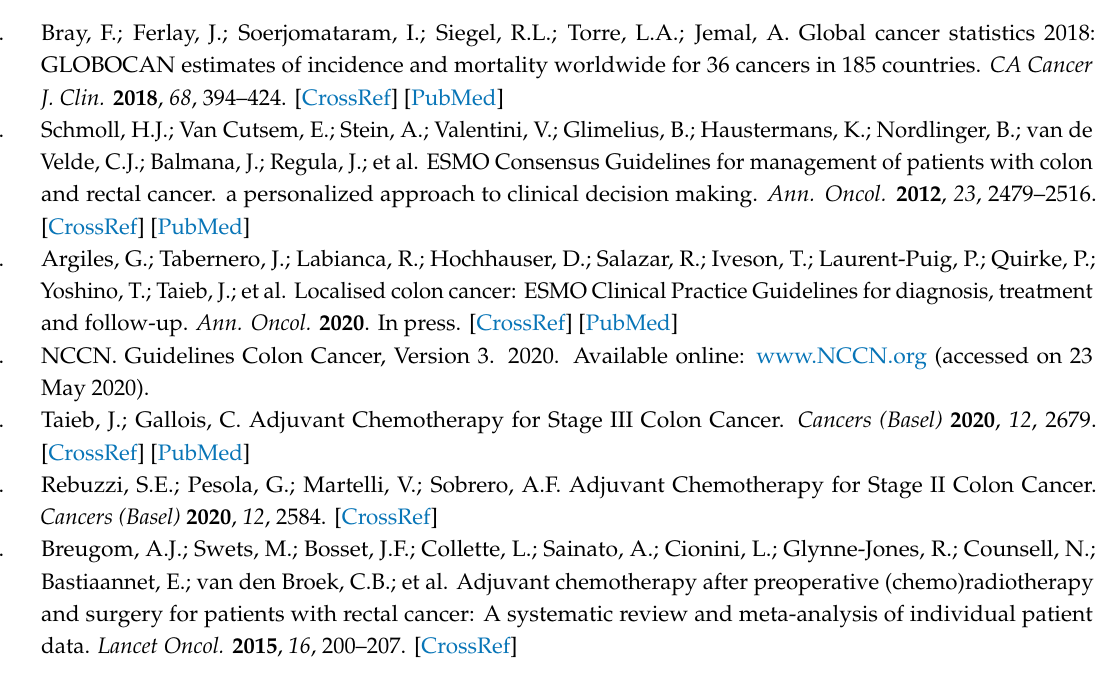
Table S1: Demographics of non-metastatic patients in a population-based Swedish Colorectal Cancer cohort diagnosed between